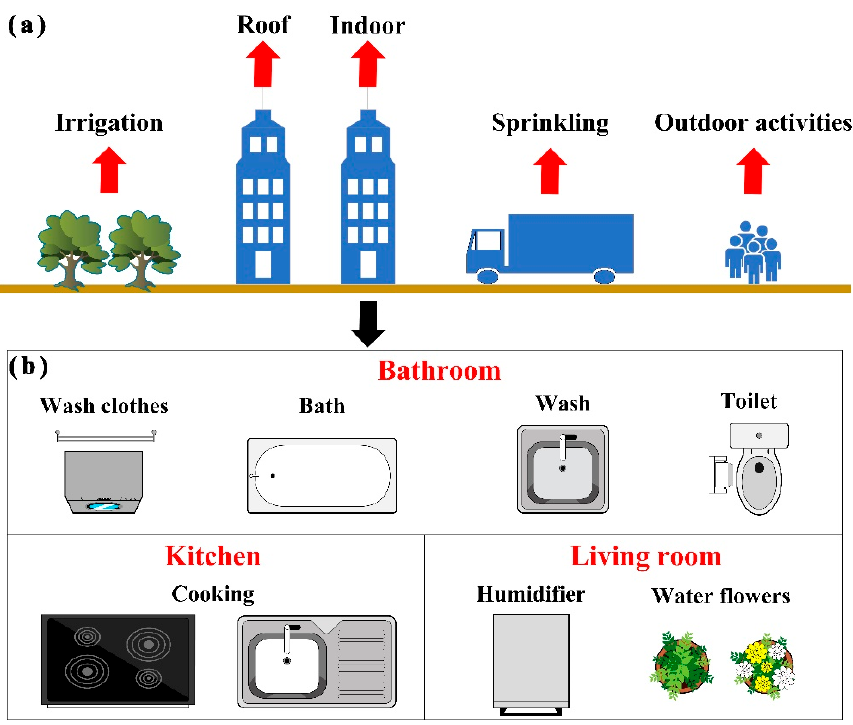
Figure 3. ( a ) Types of artificial water dissipation in urban areas and ( b ) types of artificial water dissipation inside buildings.